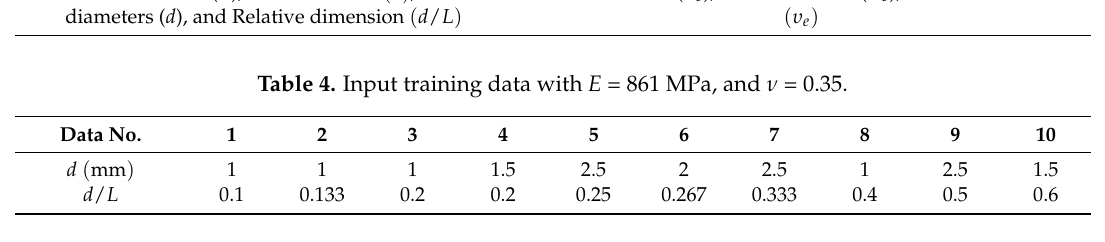
Table 5. Output training data for BCC configuration.